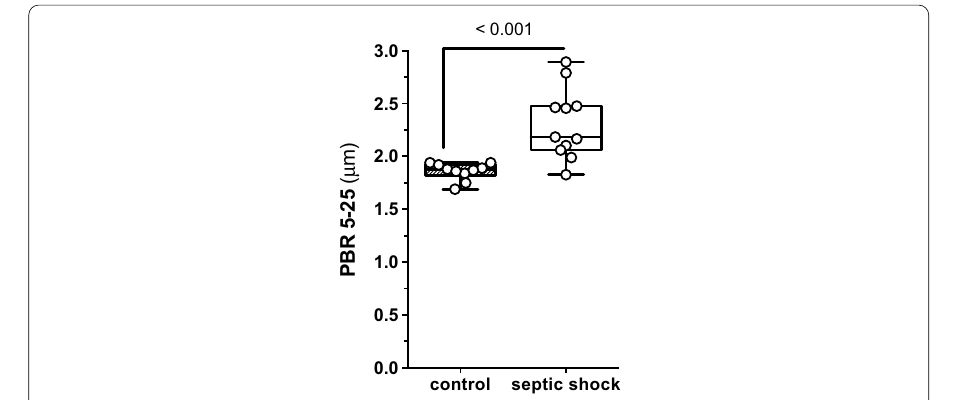
Fig. 2 Injury to the endothelial glycocalyx (eGC) in vivo. Sublingual dark field imaging in patients allows quantification of the eGC thickness as indicated by the perfused boundary region (PBR). Box and whisker plots showing results for healthy controls ( n 10) as well as patients with septic shock before = commencement of therapeutic plasma exchange (TPE) (